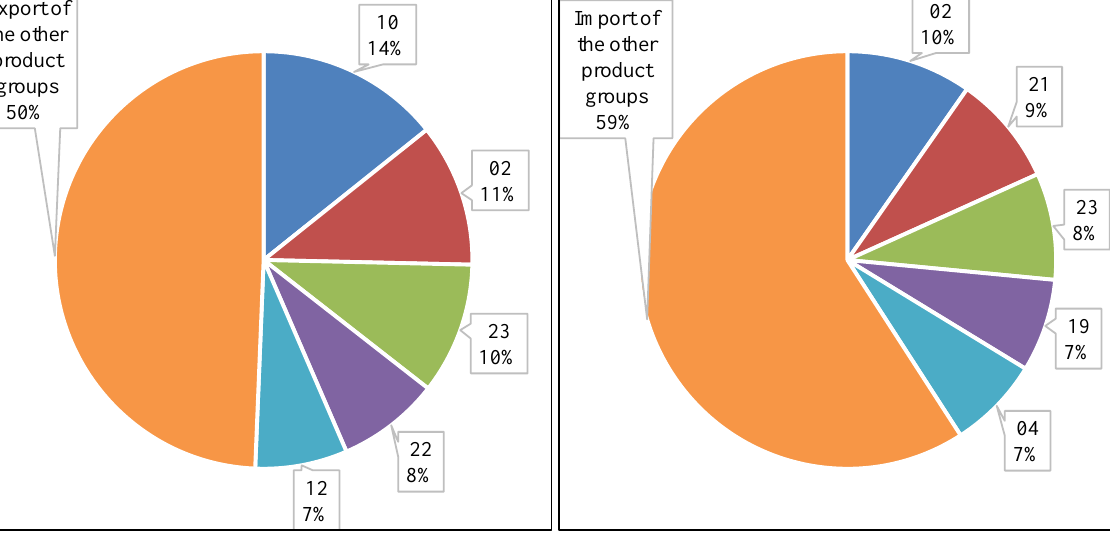
Figure 8. Major Hungarian agri-food import and export product groups, 2019 ; Source: Author’s composition based on WITS [18]